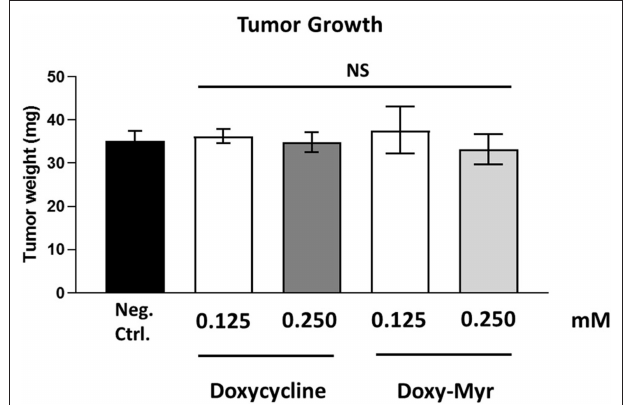
FIGURE 10 | Doxycycline and Doxy-Myr have no effect on tumor growth. MDA-MB-231 cells and the well-established chorio-allantoic membrane (CAM) assay in chicken eggs were used to quantitatively measure tumor growth. An inoculum of 1 × 10 6 MDA-MB-231 cells was added onto the Upper CAM of each egg (on Day E9) and then eggs were then randomized into groups. On day E10, tumors were detectable and they were then treated daily for 8 days with vehicle alone (1% DMSO in PBS), Doxycycline or Doxy-Myr. After 8 days of drug administration, on day E18 all tumors were weighed. Note that Doxycycline and Doxy-Myr did not have any significant effects on tumor growth. Averages are shown ± SEM. NS, not significant.